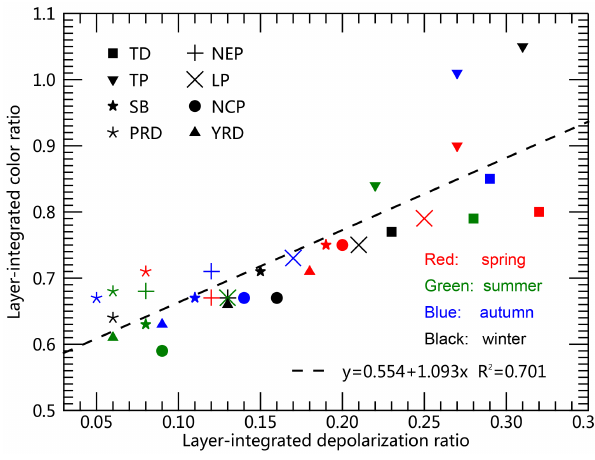
Figure 5. Seasonal average layer-integrated aerosol color ratios ver- sus layer-integrated aerosol depolarization ratios over the eight rep- resentative study regions in